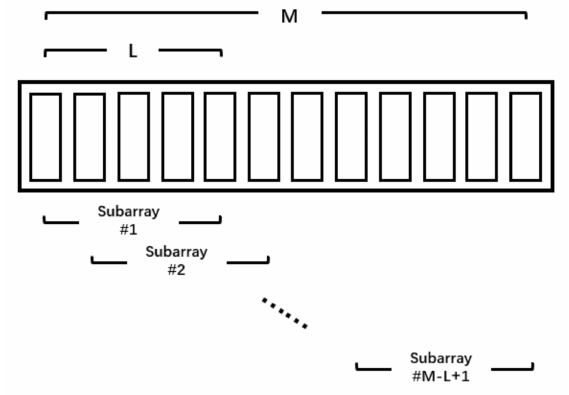
Figure A2. Illustration of